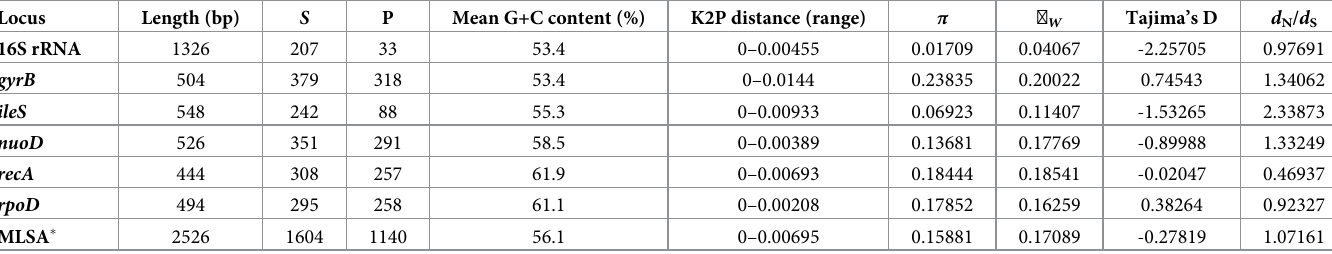
Table 1. Gene characteristics of 11 Pseudomonas